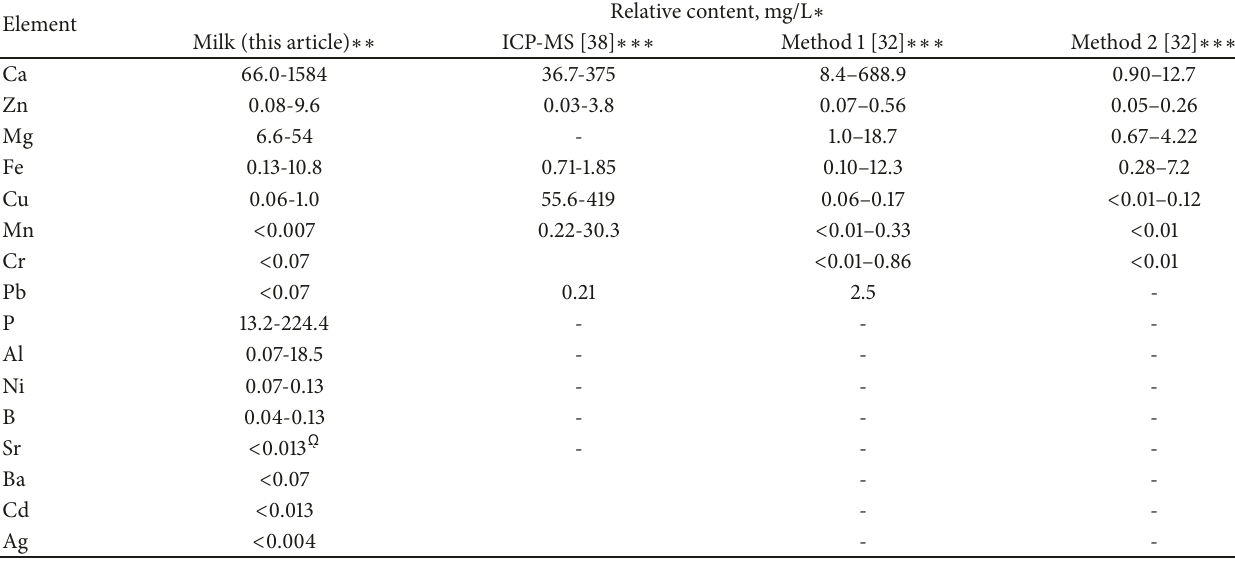
Table 3: The comparison of the content of elements in the lyophilized milk preparation preparations and literature data.